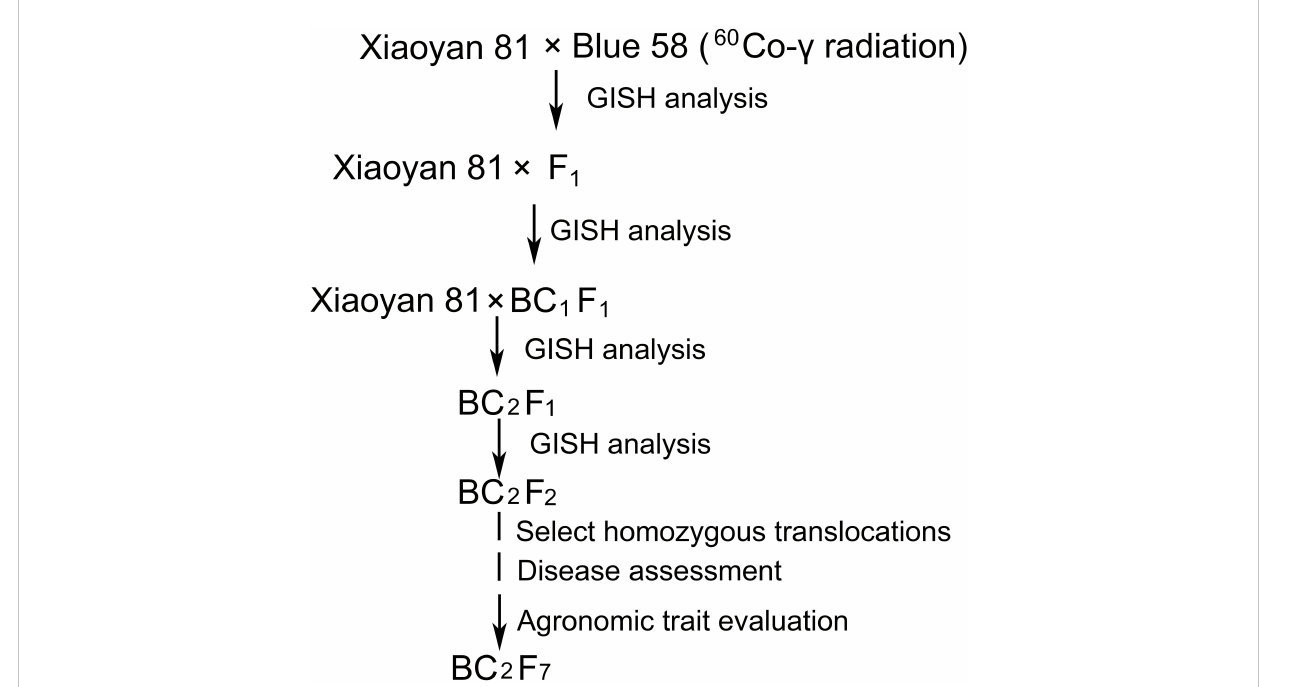
FIGURE 1 Procedure for producing wheat – Th. ponticum 4Ag translocation